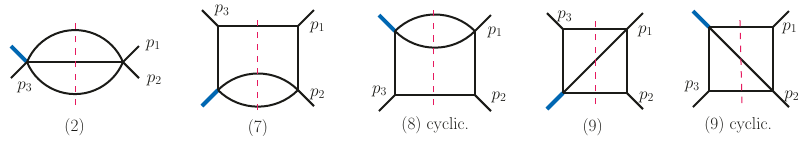
Figure 4 . Master integrals probed by s 12 -triple